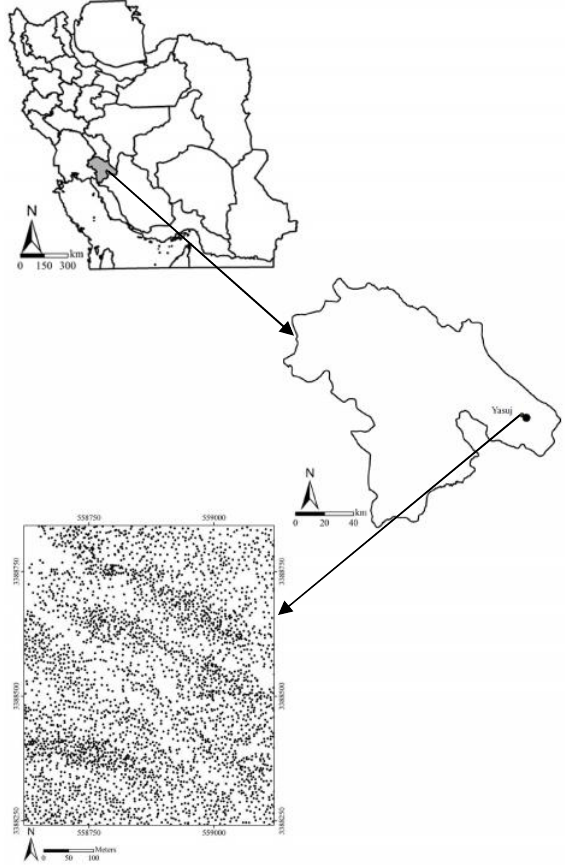
Figure 1. Map identifying the location of Kohgiluye-va- BoyerAhmad province relative to Iran and the study area.